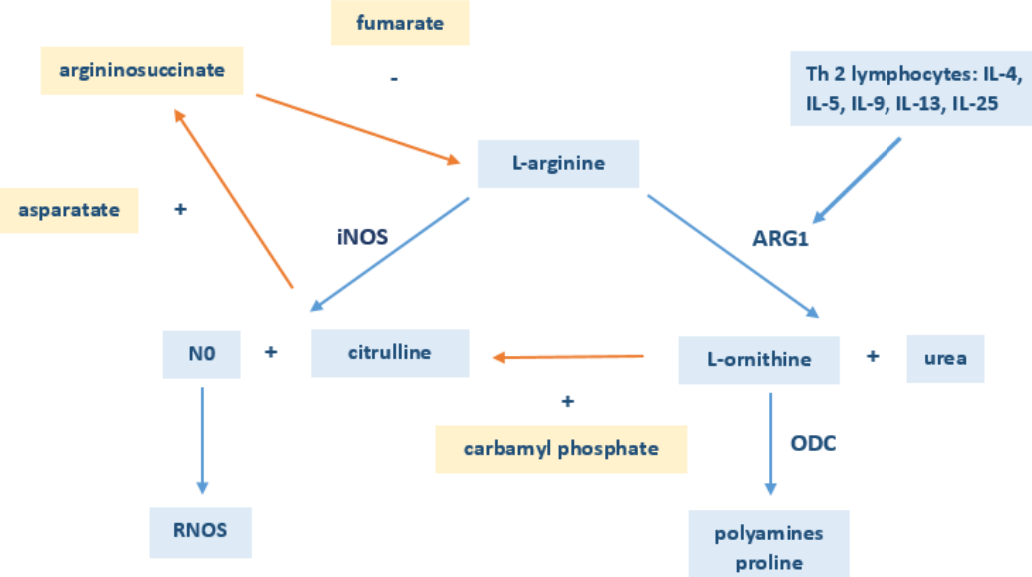
Figure 3. Metabolism of arginine in asthmatic children. The immature immune system in children manifested by decreased levels of T helper cells (Th 2) and inflammatory cytokines (IL-4, IL-5, IL-9, IL-13, IL-25) determines the decreased activity of arginase and the elevated level of arginine in the blood. Arginine cooperates with other metabolites within the network that affect each other’s concentrations. ARG1-arginase; iNOS-inducible nitric oxide synthase; RNOS-reactive oxygen species; ODC-ornithine decarboxylase.